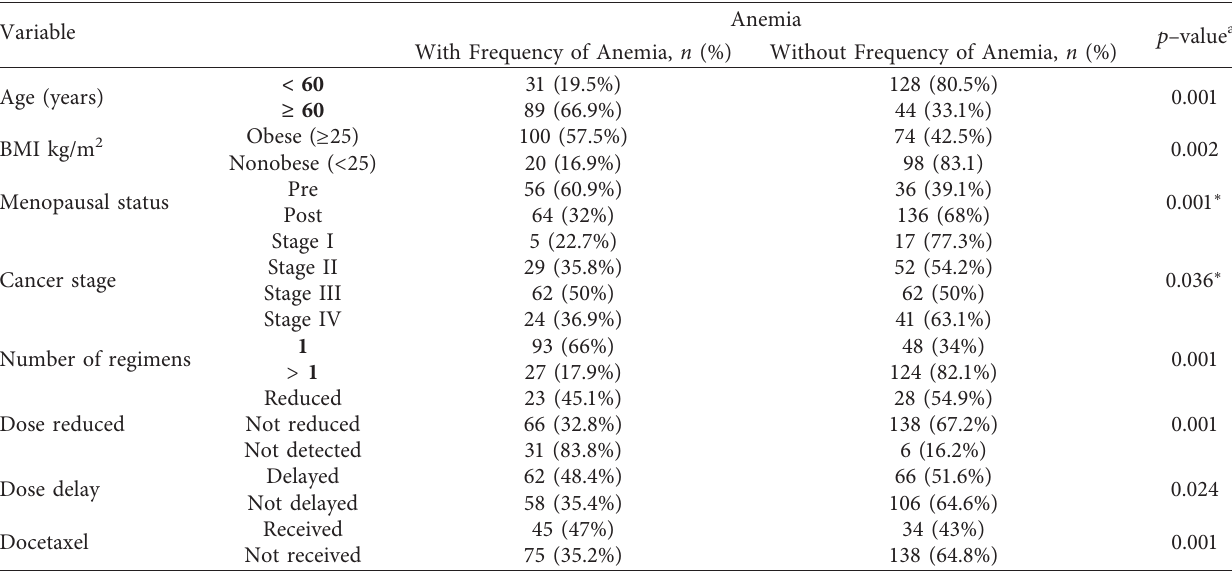
Table 3: Association between prevalence of anemia and demographic and clinical